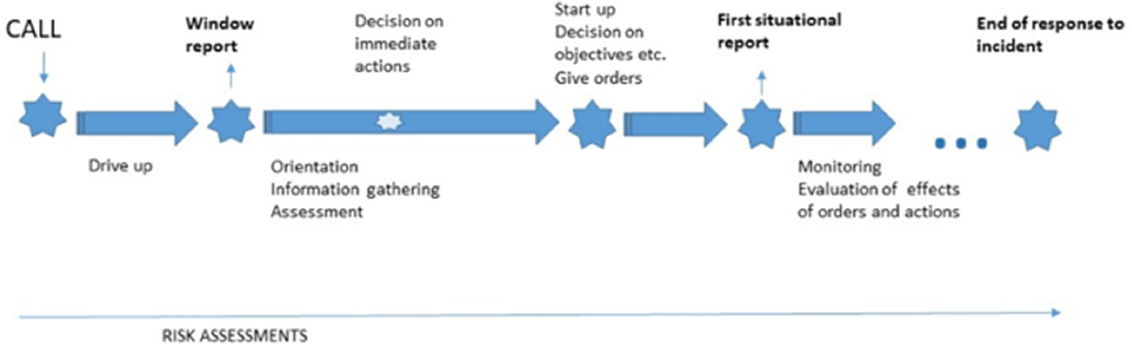
Figure 1. The most important phases (arrows) and actions (stars), where the IC-student should report to higher command or make decisions [58].